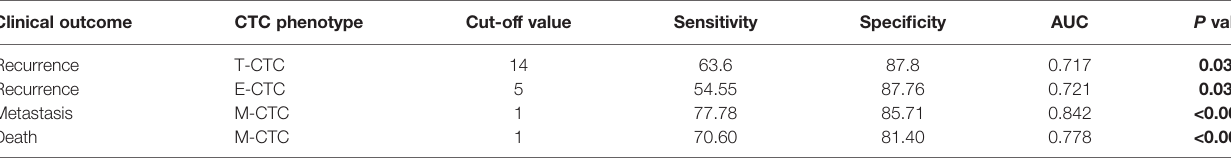
TABLE 2 | ROC curves of PoV CTCs phenotype counts on postoperative progression. Clinical